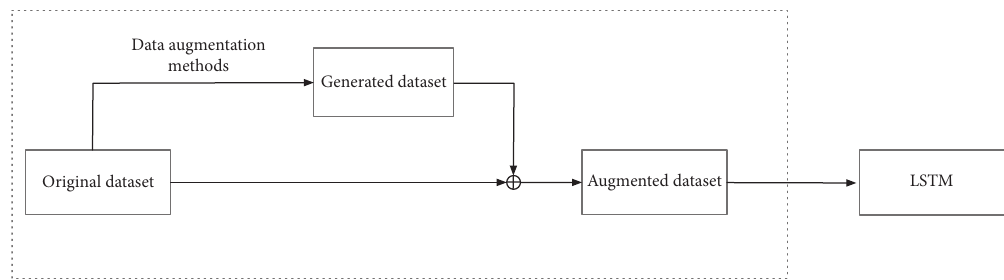
Figure 4: The diagram about how the augmented data are utilized in